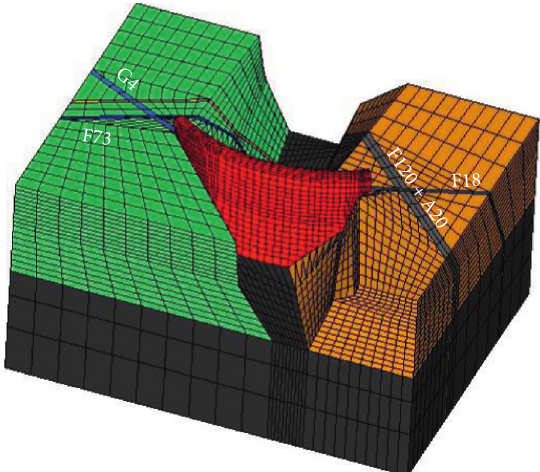
Figure 17: The 3D model of the Longyangxia dam. Table 2: Permeability coefficients of each region in the 3D